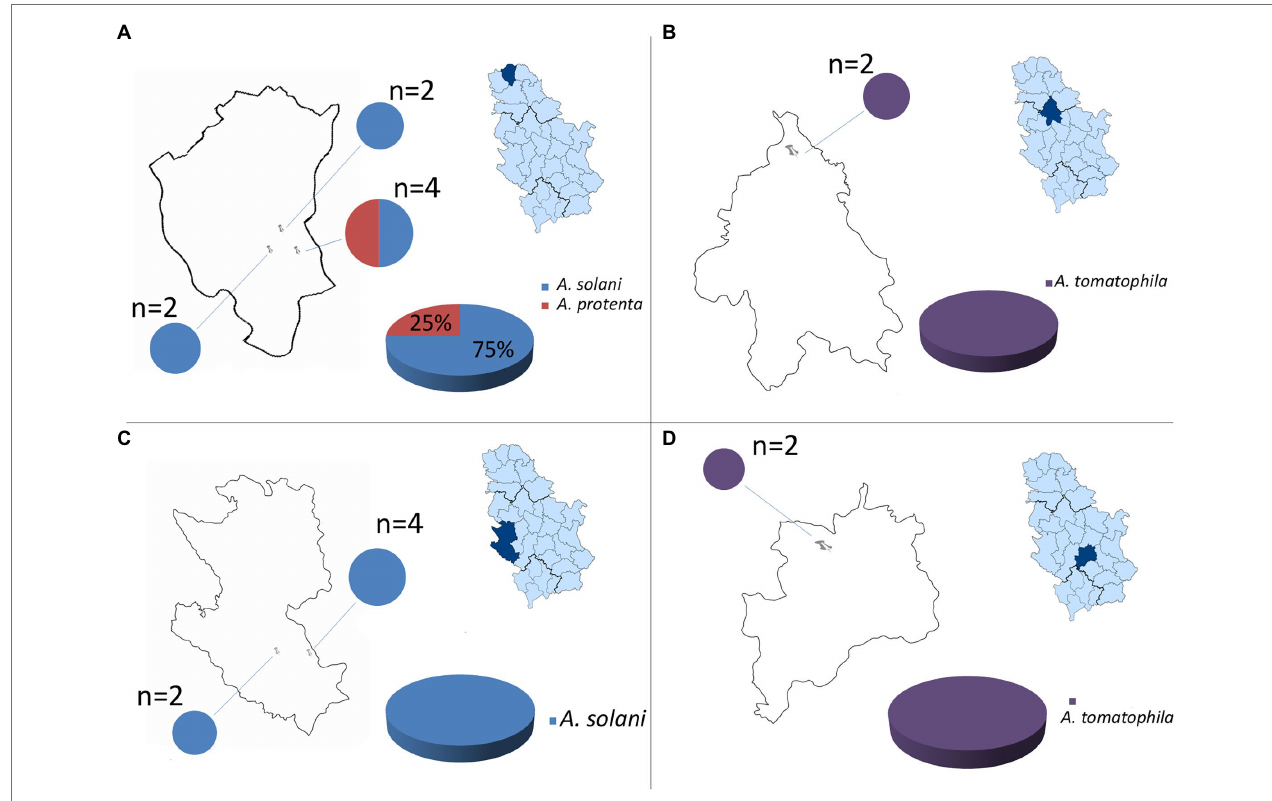
FIGURE 2 | Geographical distribution of large-spored Alternaria spp.: (A) North Bac ̌ ka district (locality: Zobnatica), (B) Belgrade district (locality: Borc ̌ a), (C) Zlatibor district (localities: Drmanovic ́ i, Kladnica), and (D) Rasina district (locality: Velika